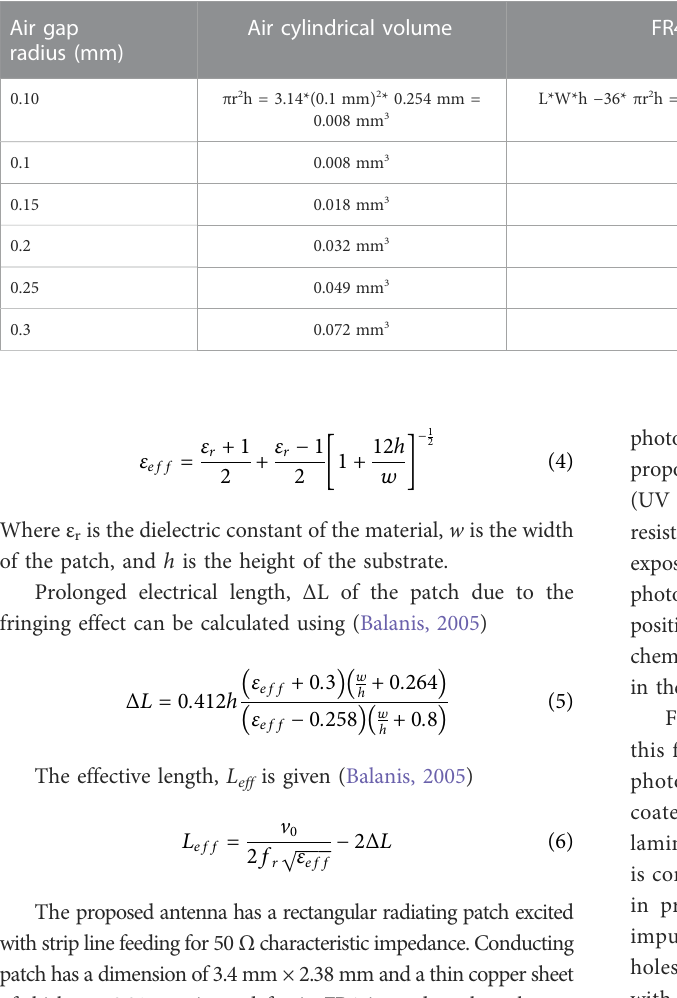
TABLE 4 Cylindrical air gap volume Vs. FR4 Volume correlation of proposed